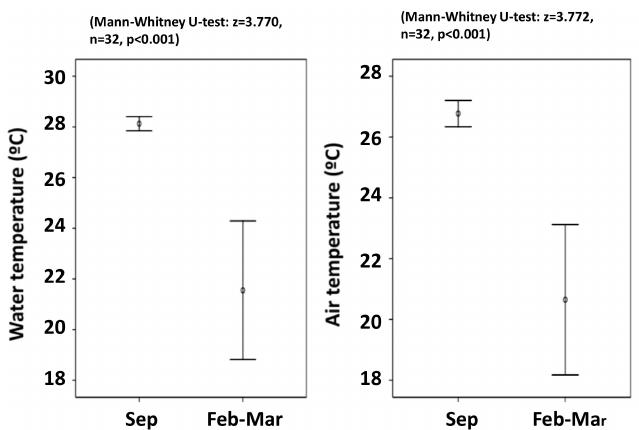
Figure 3. Difference in sea surface temperature along the cruise track between Tokyo and Honolulu between September 2010 and February–March 2012.